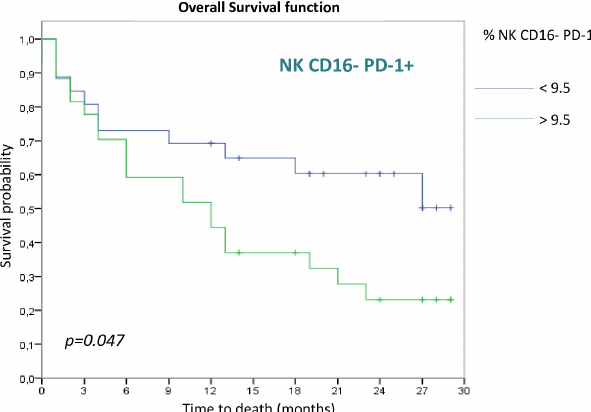
Figure 4. Kaplan Meier curve according to NK CD16 − PD-1+.